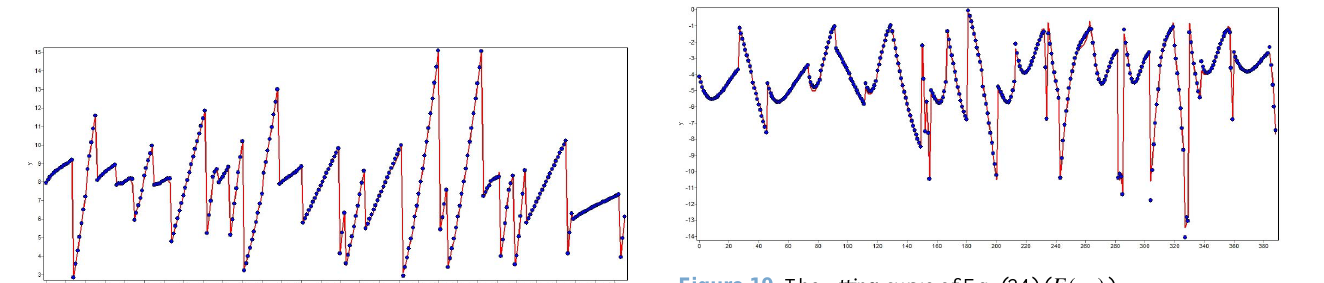
Figure 19. The fitting curve of Eq. (24) ( F(x 5 )